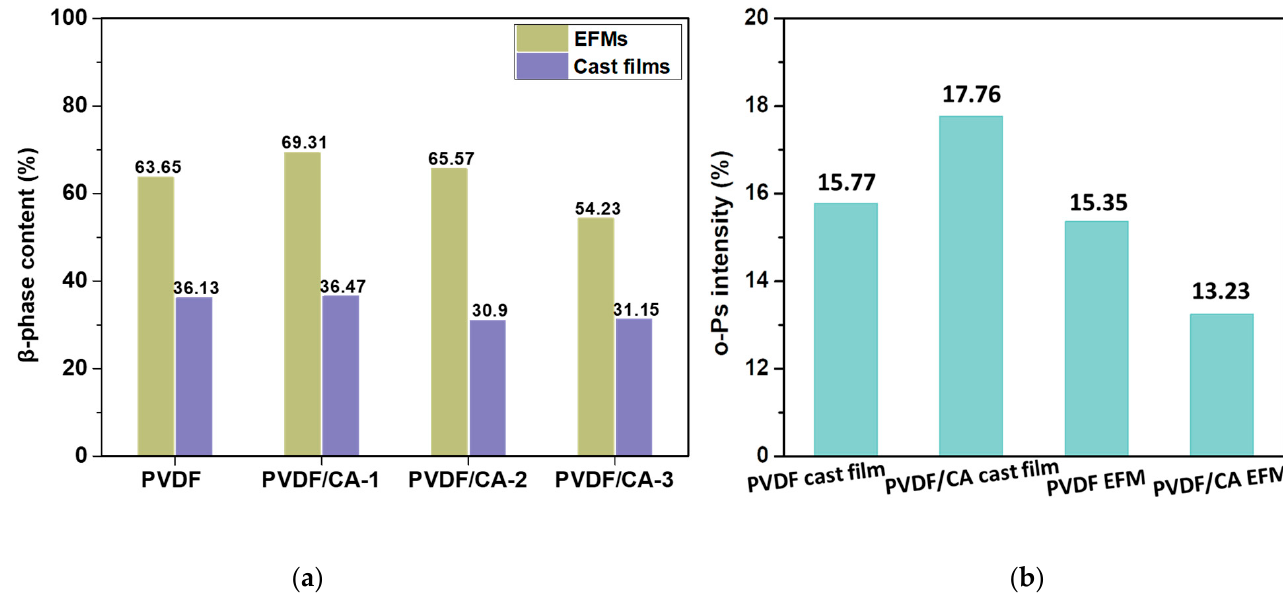
where K α (6.1 × 10 4 cm 2 /mol) and K β (= 7.7 × 10 4 cm 2 /mol) are the absorption coefficients at 763 cm − 1 and 840 cm − 1 , and A α and A β are the absorbances of the α -phase at 763 cm − 1 and the β -phase at 840 cm − 1 , respectively. F( β ) represents the relative β fraction. Figure 6 illustrates the values of F( β ). The F( β ) value of PVDF powder was only 11.26%. The F( β ) of pure PVDF fibers prepared via electrospinning significantly increased to 63.65%, while the F( β ) values increased to 69.31% in the composite membrane PVDF/CA-1. Upon increasing the content of CA, the F( β ) value decreased gradually.